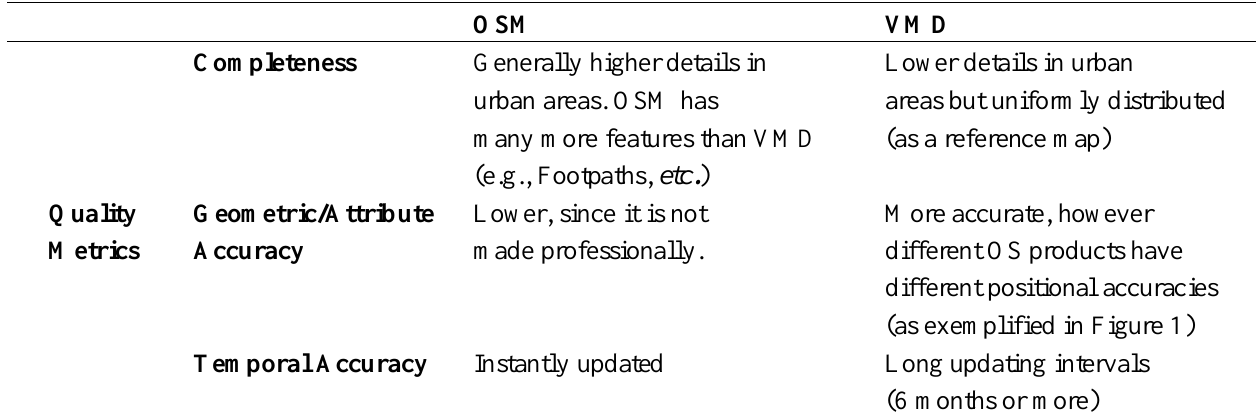
Table 1. Comparing the characteristics of OSM vs.